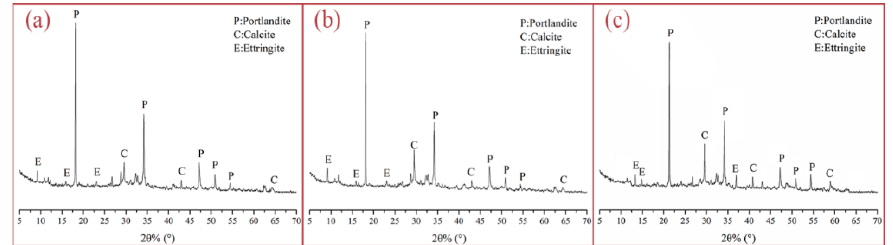
Figure 11. Diffraction results of cement slurry sample. ( a ) Unabsorbed CO 2 cement paste; ( b ) 2.20% CO 2 (mechanical agitation); ( c ) 2.20% CO 2 (ultrasonic vibration agitation).